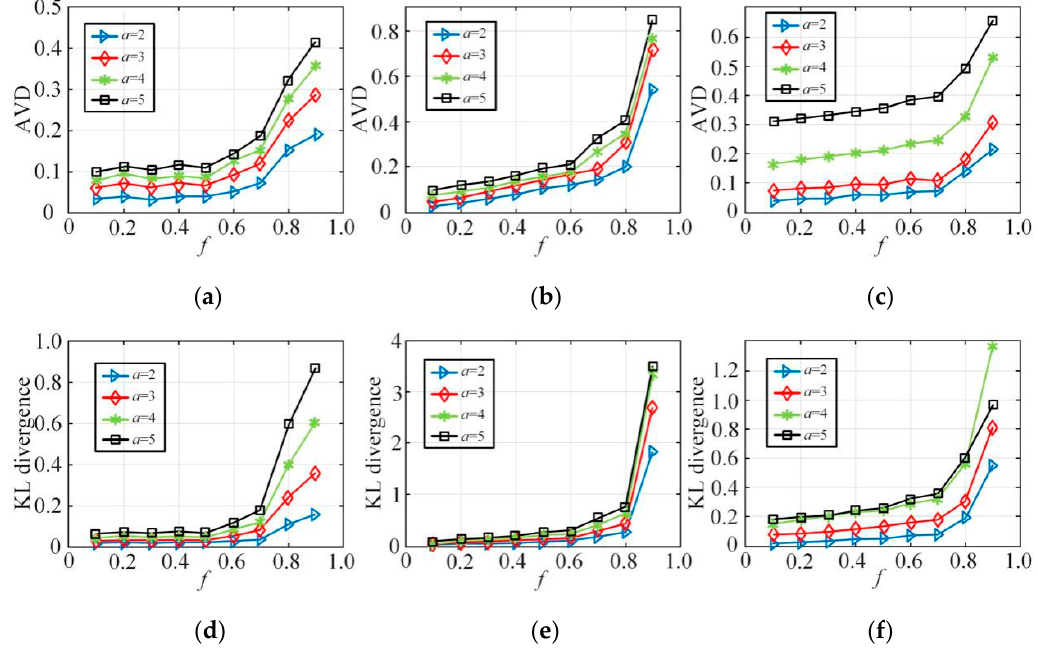
Figure 9. The estimation deviation of 𝑎 -dimensional joint probability distribution: ( a ) NLTCS ( 𝑘 = 2 ), ( b ) Adults ( 𝑘 = 2 ), ( c ) TPC-E ( 𝑘 = 2 ), ( d ) NLTCS ( 𝑘 = 2 ), ( e ) Adults ( 𝑘 = 2 ), ( f ) TPC-E ( 𝑘 = 2 ).